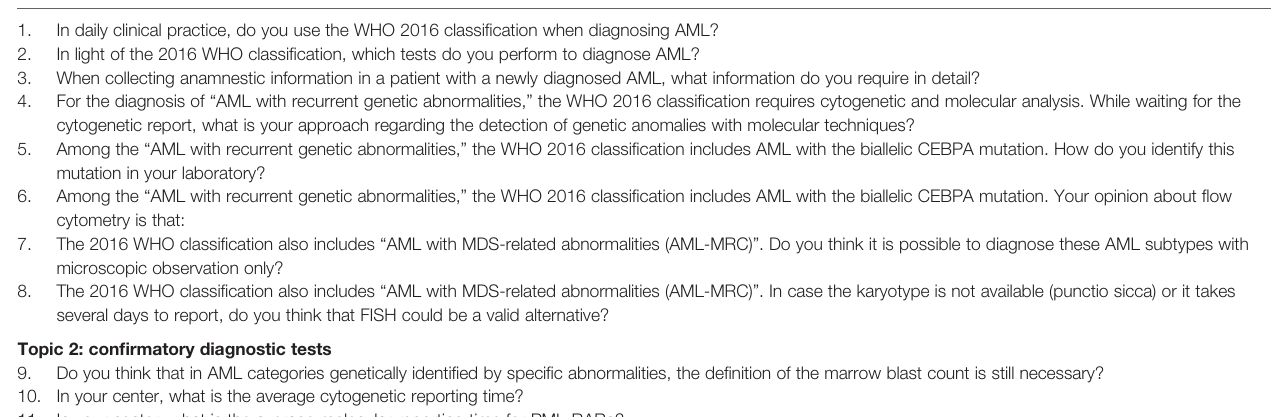
TABLE 1 | List of the 26 questions included in the survey for the four main topics. Topic 1: Application of the WHO 2016 Classi fi